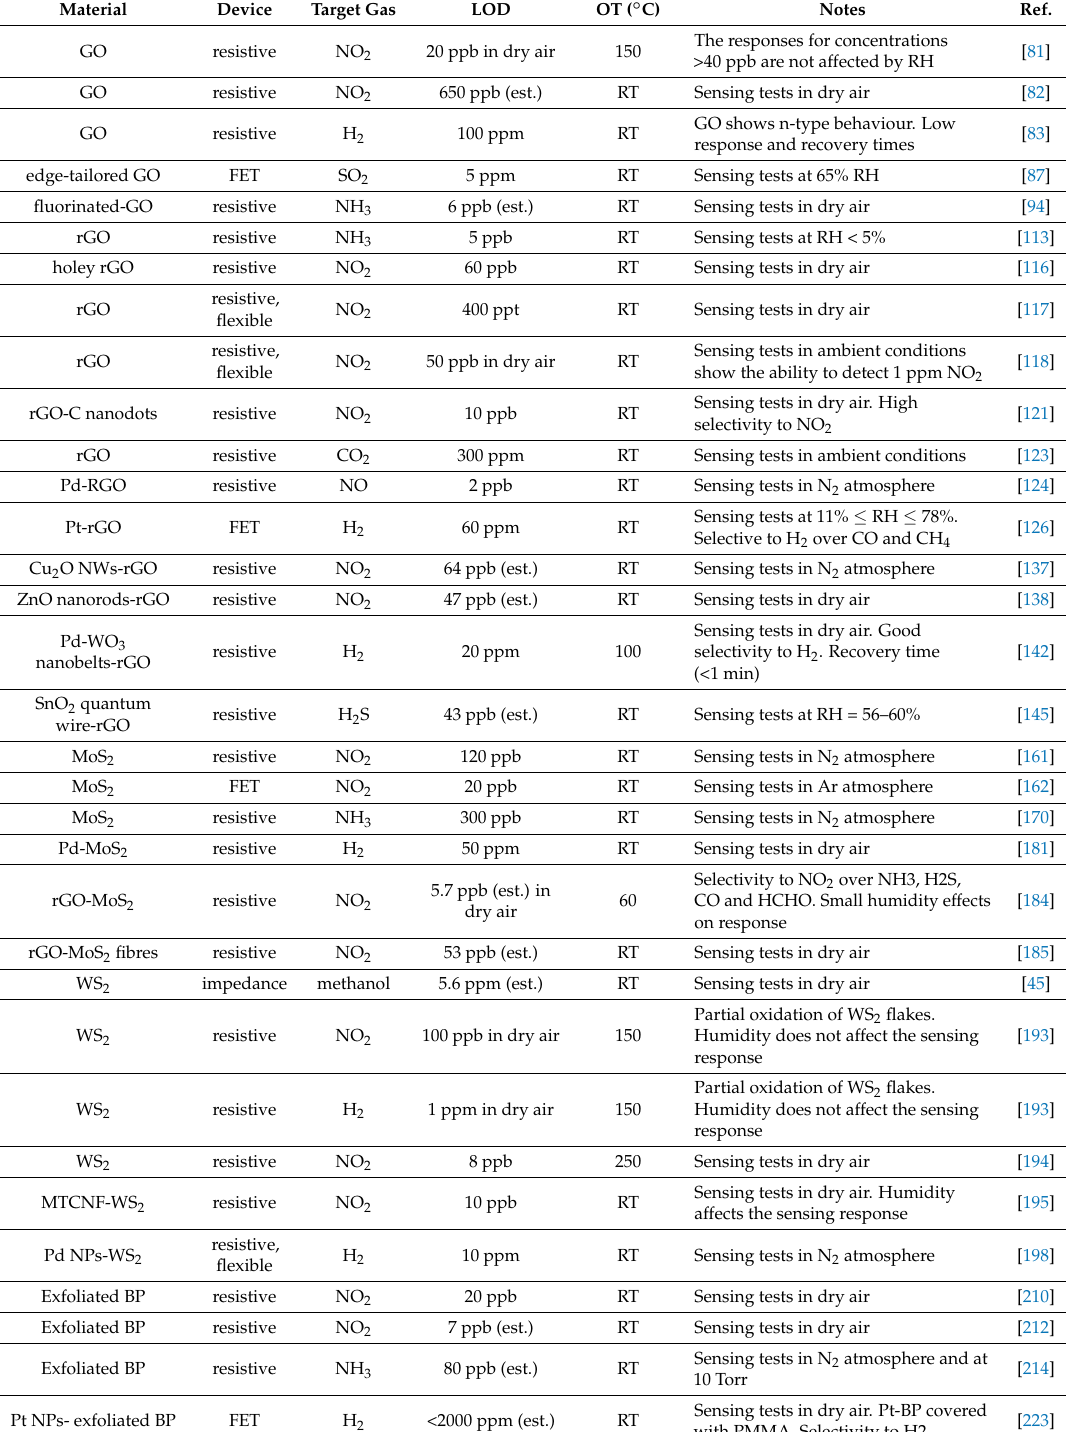
Table 1. A resume of the some of the devices reported in this paper with the lowest limit of detection.